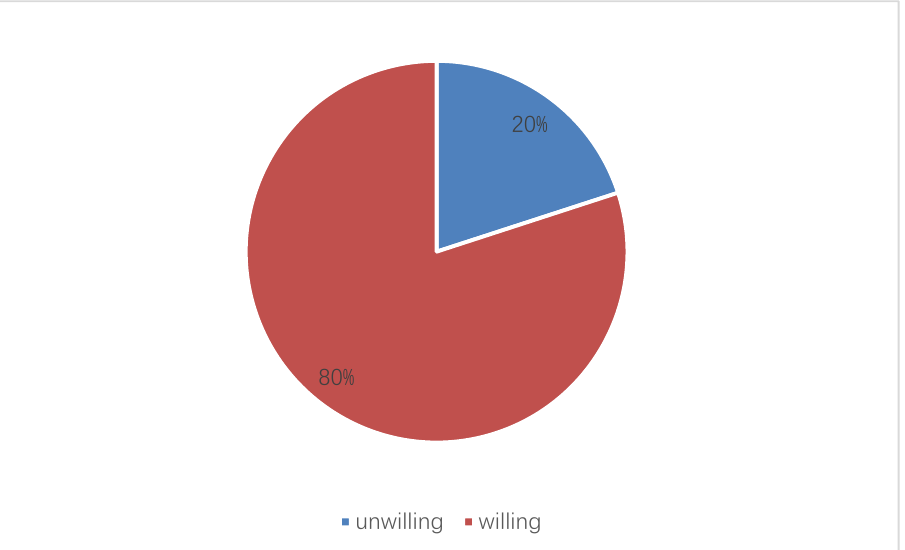
Figure 15. Consumers’ willingness to purchase organic agricultural products.